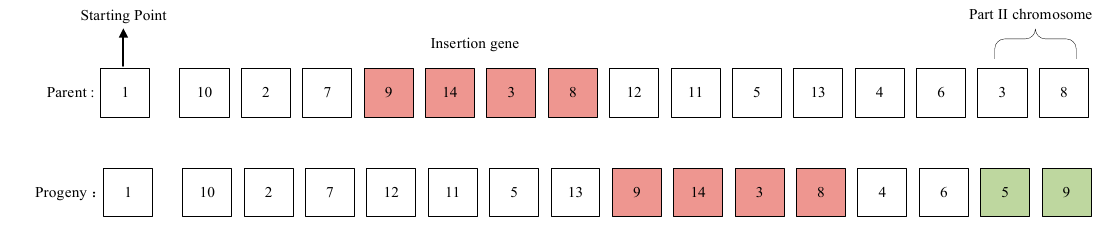
Figure 8. Insertion mutation operation ( m = 14).